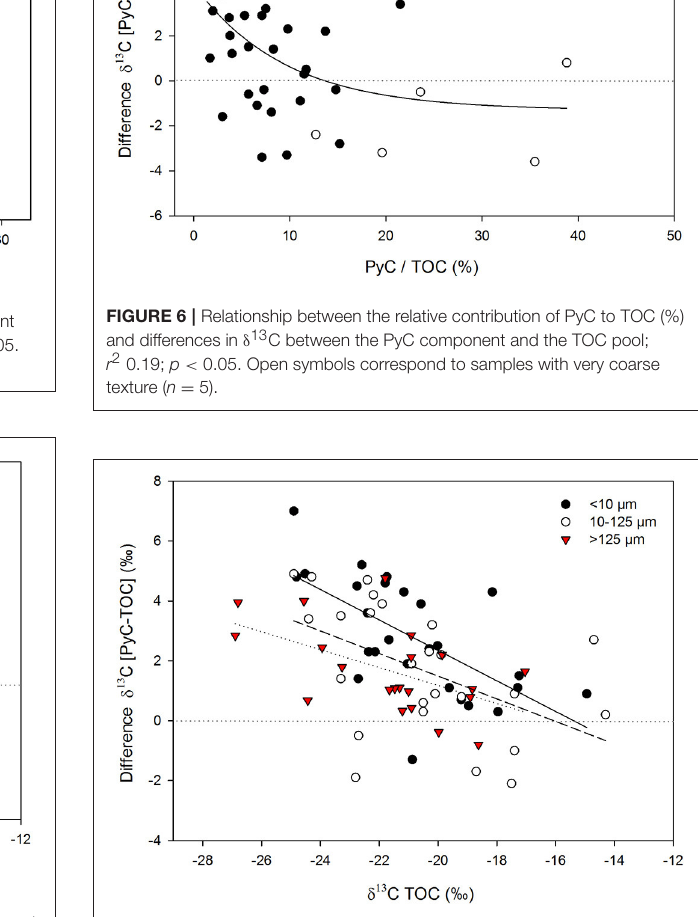
FIGURE 7 | Relationship between δ 13 C values of bulk sediment samples and differences in δ 13 C between the PyC component and the TOC pool for different size fractions; regression coefficients ( r 2 ) are 0.41 for the fractions < 10 µ m (solid line), 0.34 for the fractions between 10 and 125 µ m (dashed line), and 0.29 for the fractions > 125 µ m (dotted line); p < 0.05 for all